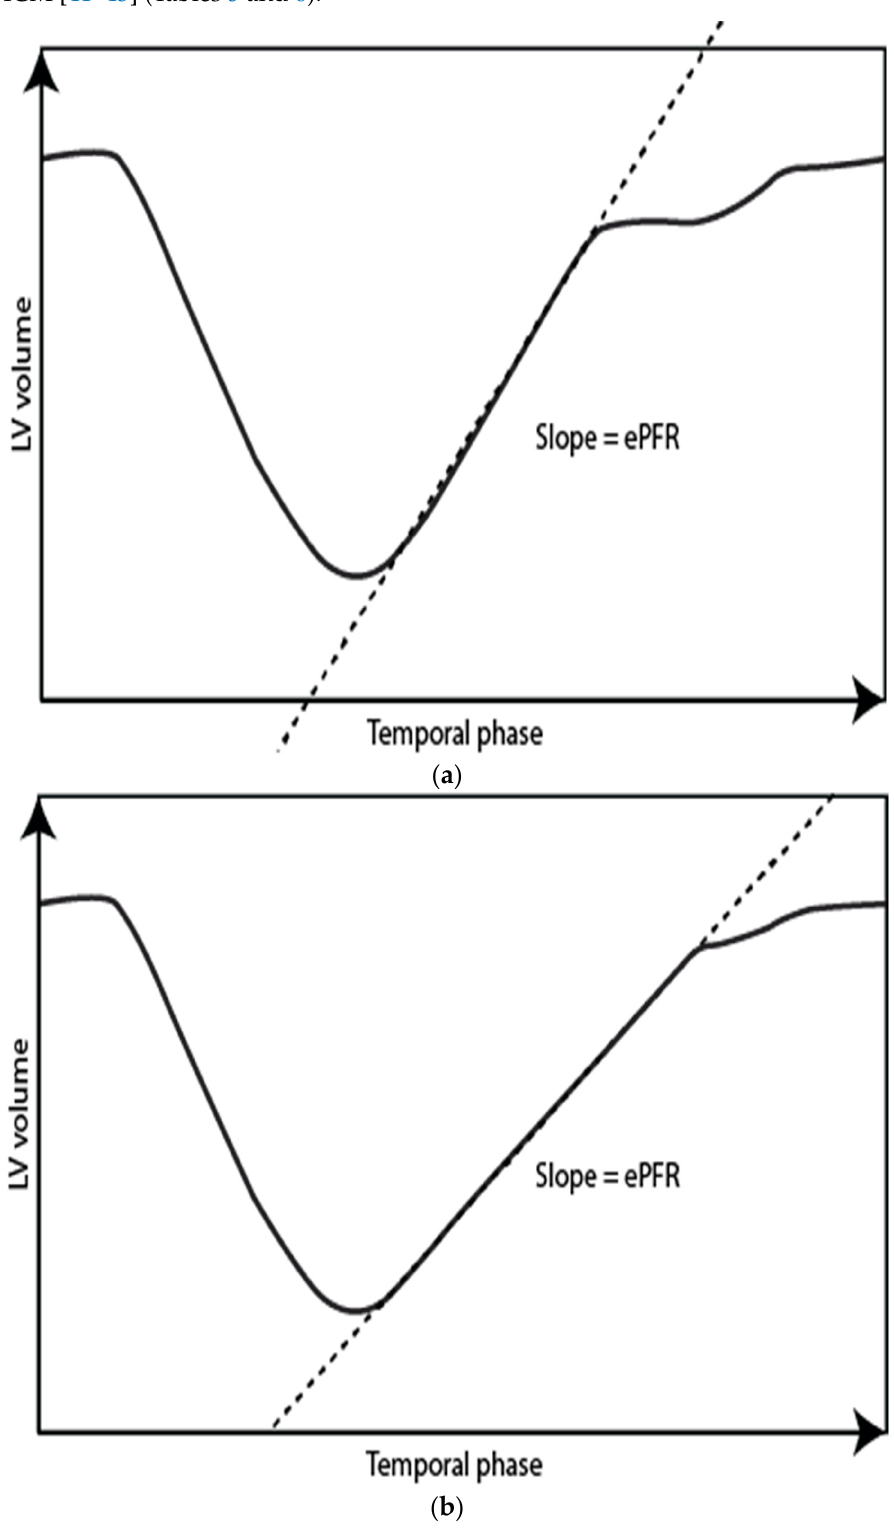
Figure 4. Left ventricle time-volume curves for a normal subject ( a) and a patient with diastolic impairment ( b) . Notice a more gradual slope in the patient with diastolic impairment corresponding to a lower early peak filling rate = ePFR.